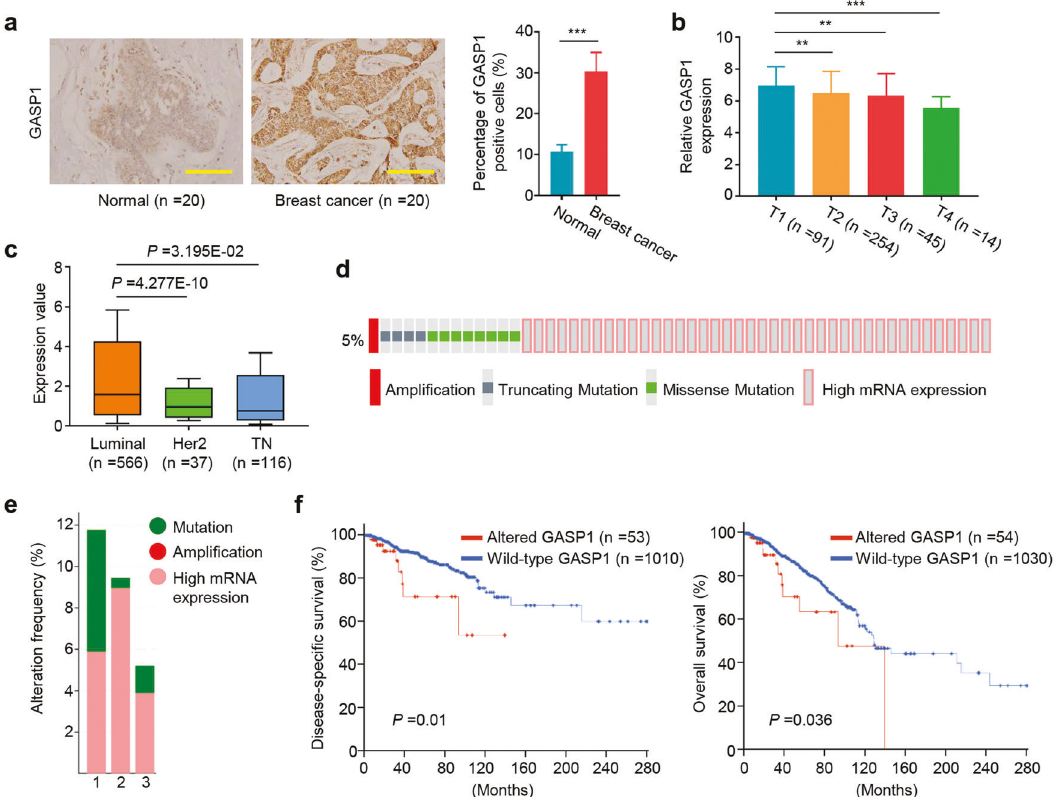
Fig. 1 Altered GASP1 in breast cancers and its association with patient survival. a Immunohistochemistry was performed to determine the level of GASP1 in breast cancers and normal breast tissues ( n = 20). Scale bar, 200 µm. b GASP1 expression in different stages of breast cancer patients (data from TCGA database). c GASP1 expression in different breast cancer subgroups, including luminal, HER2 positive, and Triple- negative types (data from UALCAN platform). d A total of 5% (54/1084) of breast cancers exhibit GASP1 alterations (data from cBioPortal). e The frequency of GASP1 alterations in different pathological types of breast cancer, including mutation, genomic ampli fi cation, and high mRNA expression (data from cBioPortal). Numbers 1, 2, and 3 represent Invasive Mixed Mucinous Carcinoma, Invasive Lobular Carcinoma, and Invasive Carcinoma (NOS, respectively. f The association of GASP1 alterations with disease-speci fi c survival and overall survival in breast cancer patients. Data were presented as mean ± SD. ** P < 0.01; *** P <